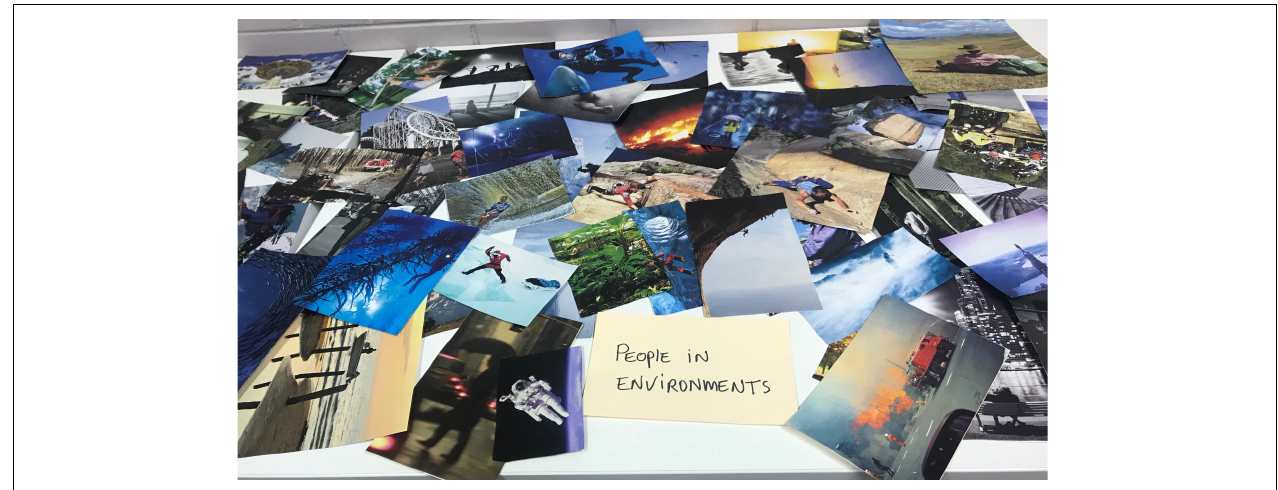
FIGURE 1 | The pre-cut image buffet for single-session art